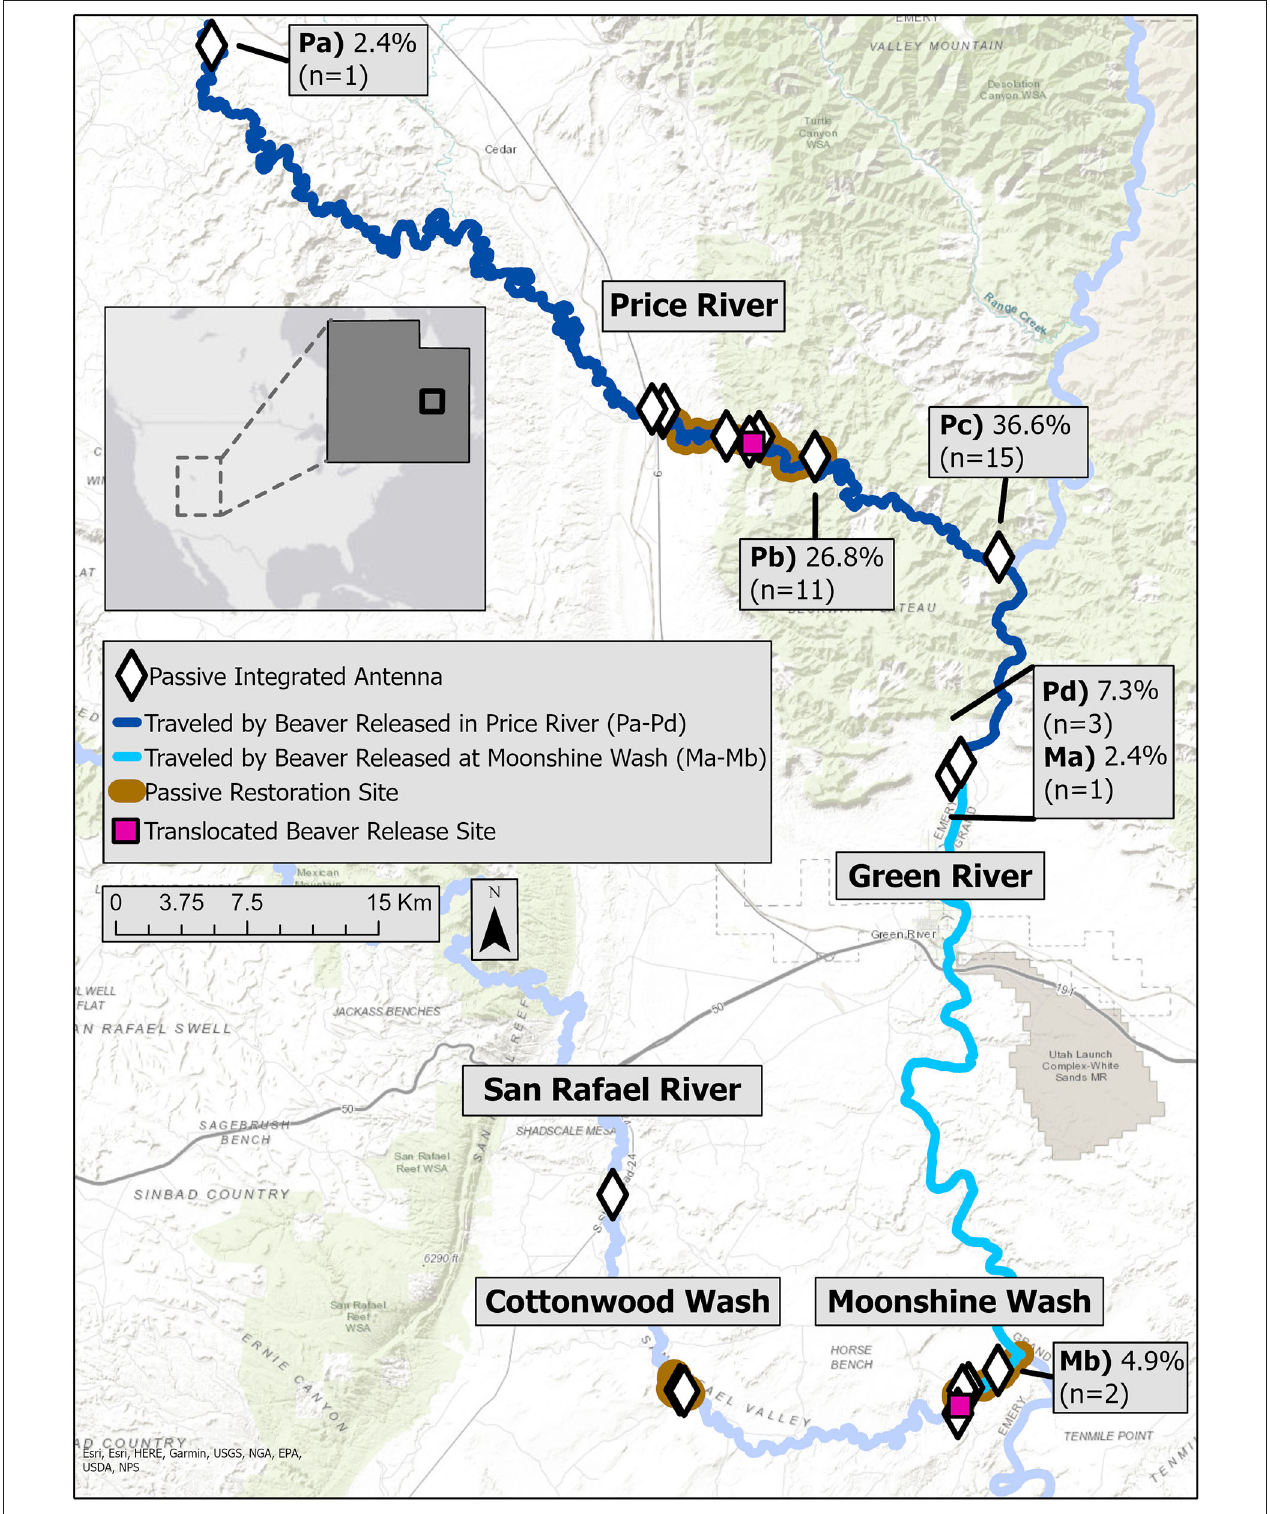
FIGURE 2 | Passive restoration sites and surrounding stretches of river on the Price River and the lower San Rafael River at Cottonwood Wash and Moonshine Wash in east-central Utah, USA. Inset text boxes labeled with letters represent the proportion and number of translocated beavers detected at certain passive